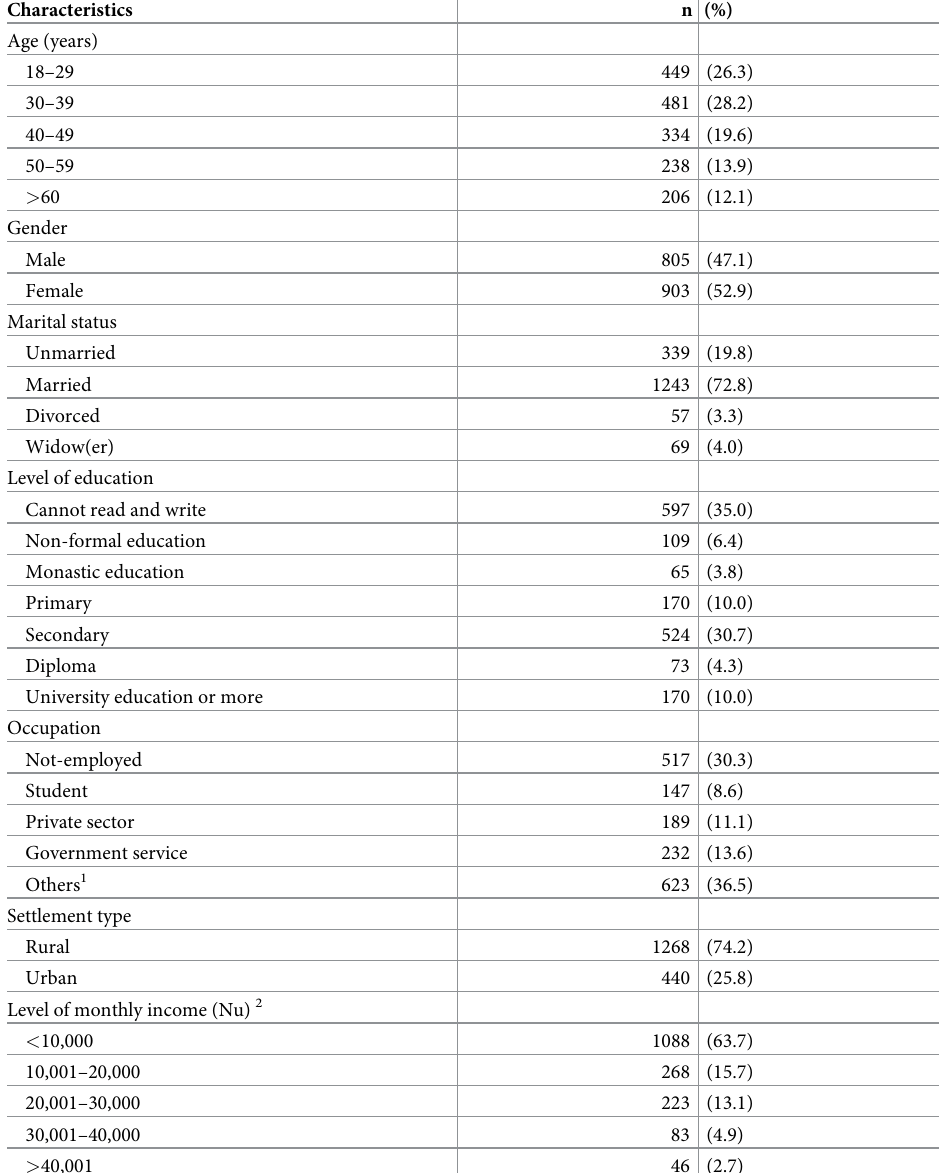
Table 1. Socio-demographic characteristics of the respondents of the knowledge, attitude and practice on COVID-19 preventive measures survey in Bhutan, January–February, 2022 (n = 1708).